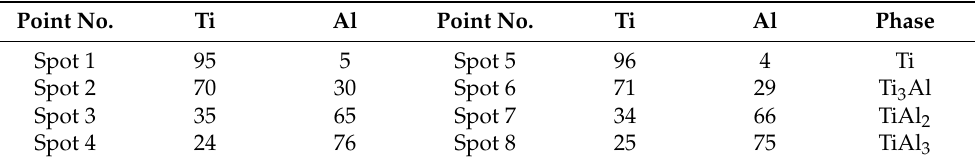
Table 2. Typical chemical compositions of the Ti/Ti–Al interface zone detected by Energy Dispersive X-ray Spectrometry (EDXS).